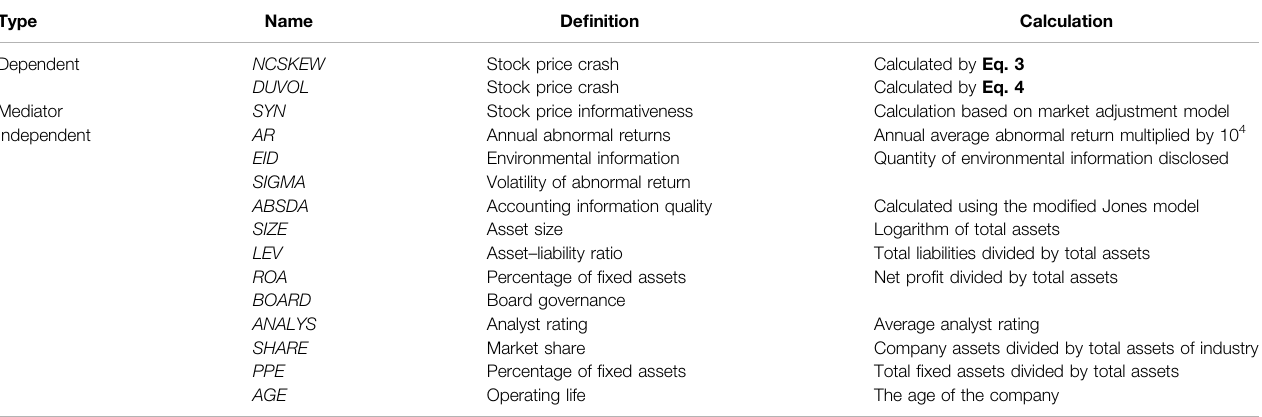
TABLE 1 | De fi nitions of main